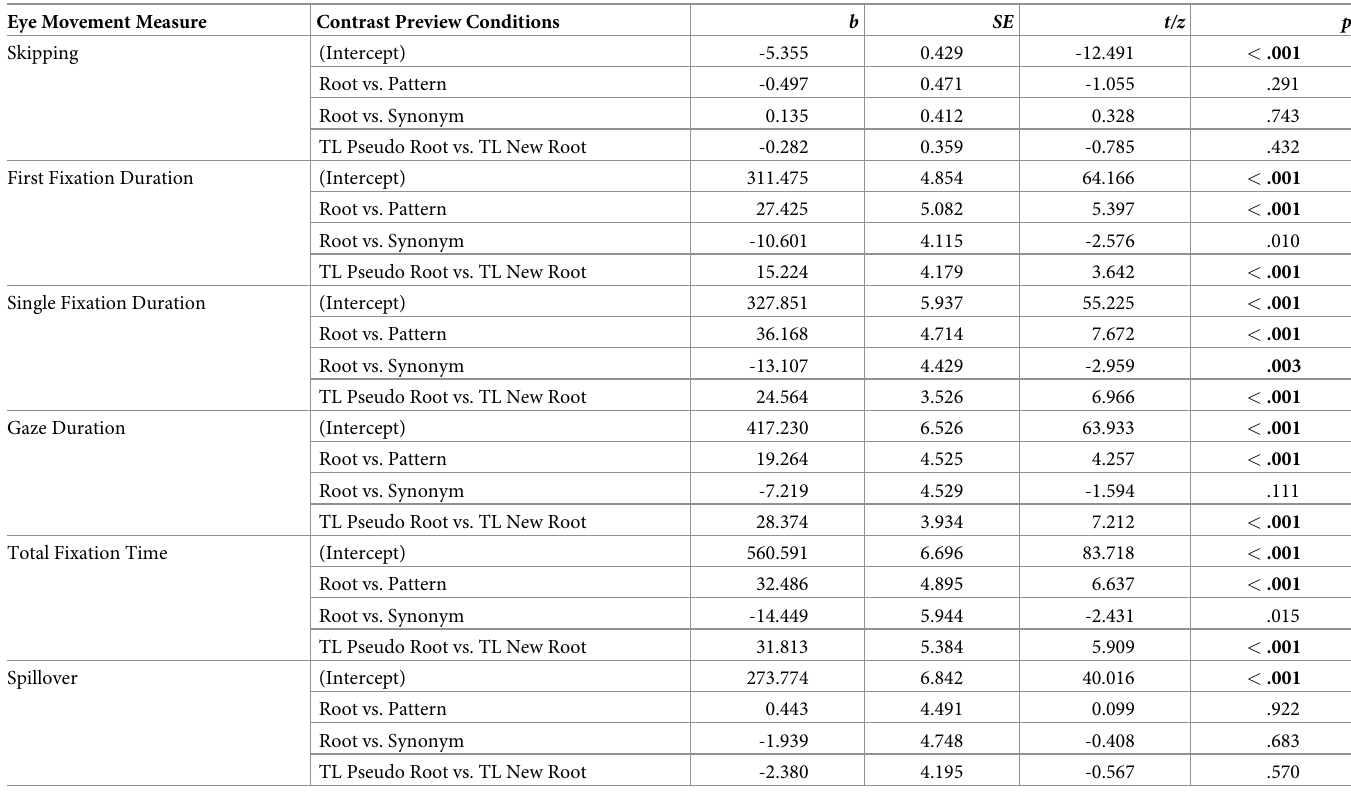
Table 5. Linear mixed models outputs for the additional pre-specified